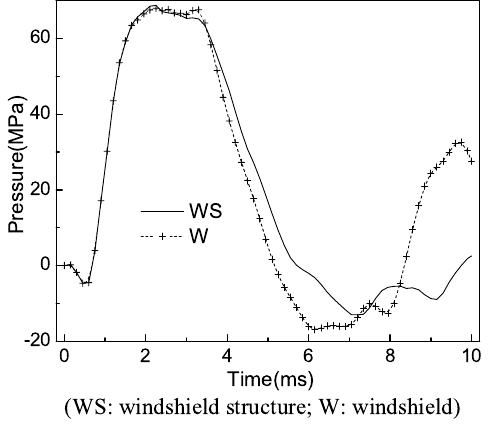
Fig. 27. Time history of pressure at the center on outer surface of windshield.